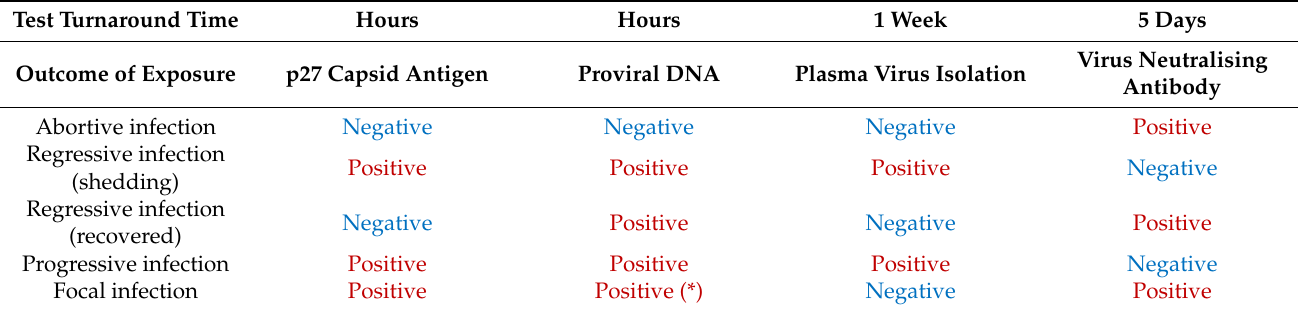
Table 1. Diagnostic test results for each exposure outcome and test turnaround